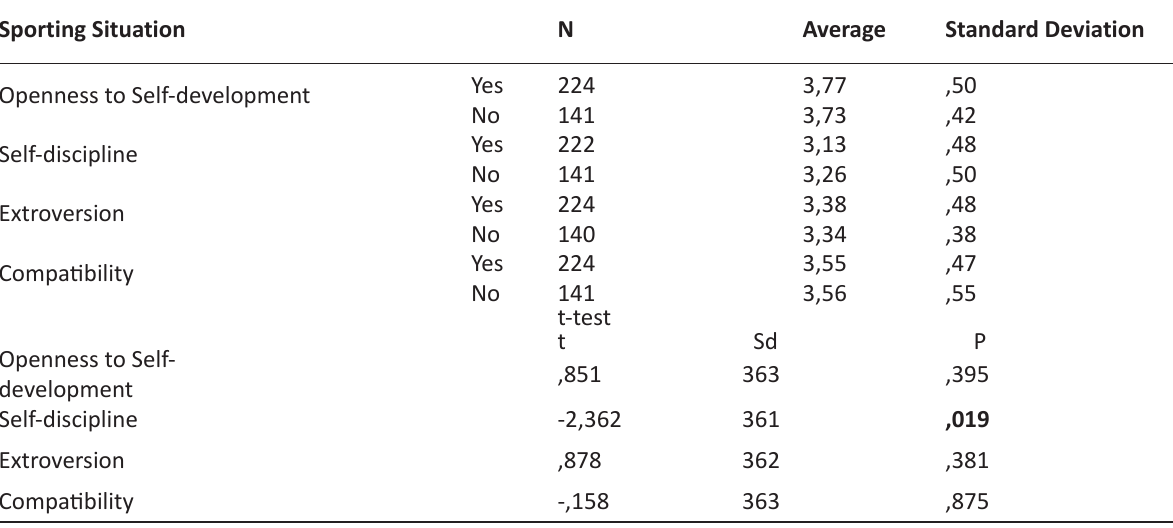
Table 2. T-test results between personality traits score averages of individuals who do sports and who do not. Sporting Situation